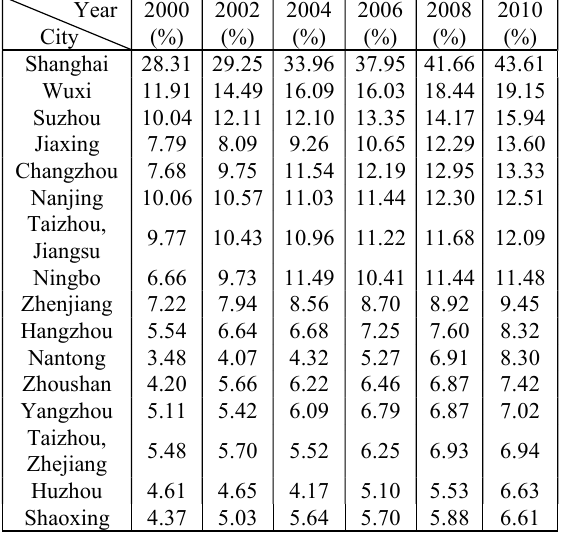
Table 2 . Urban land area index of each